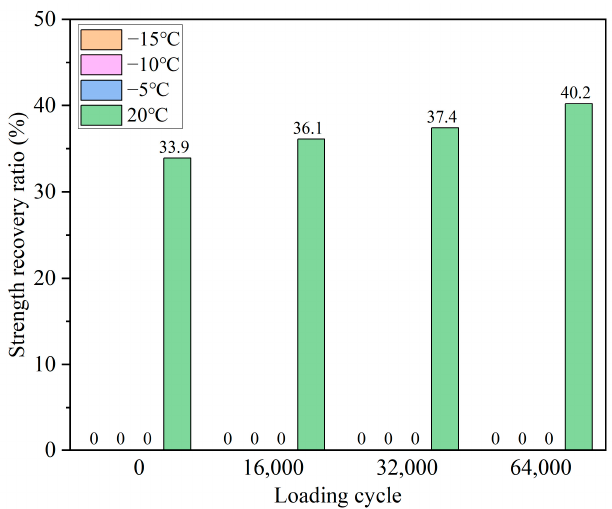
Figure 10. Healing ratio of non-capsule asphalt concrete beams after compression loading at different service temperatures.